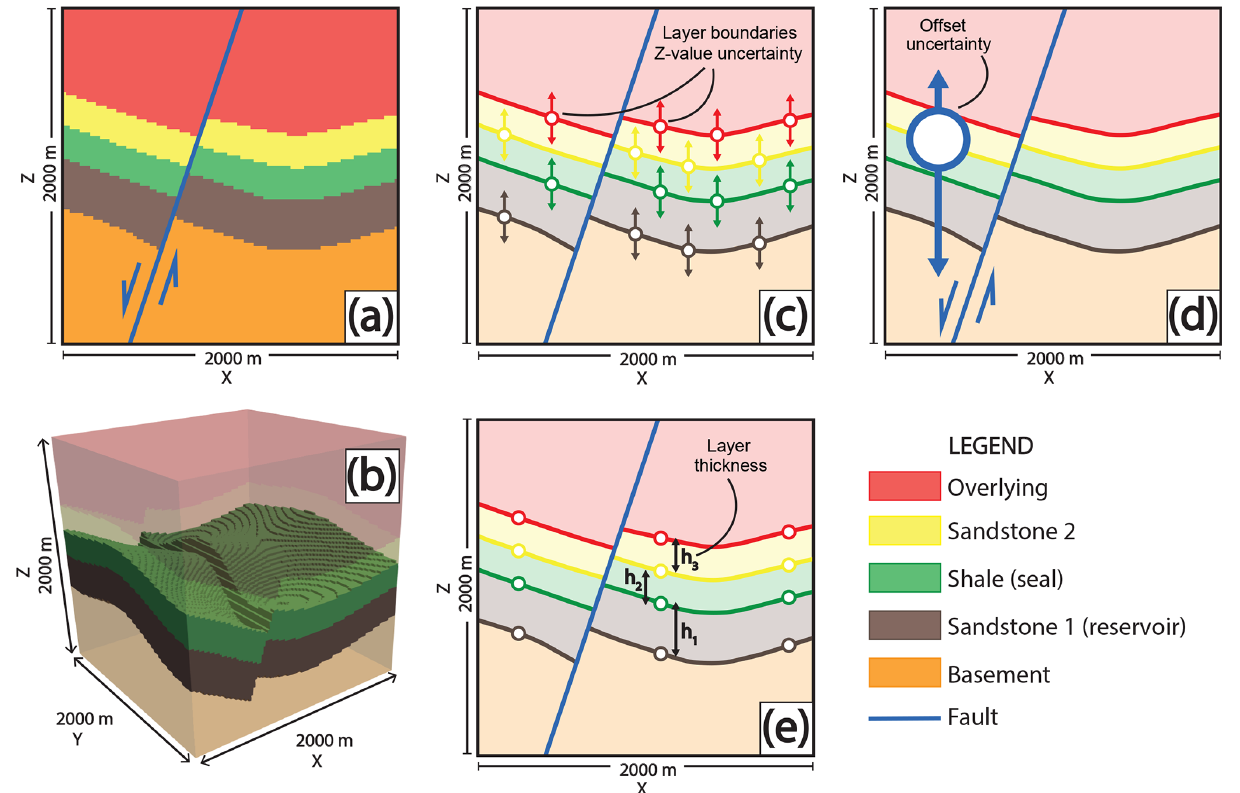
Figure 3. Design of the 3-D structural geological model. A 2-D cross section through the middle of the model ( y = 500m), perpendicular to the normal fault (parallel to the x – z plane), is shown in (a) . A 3-D voxel representation of the model, highlighting the reservoir and seal formations, is visualized in (b) . In (c) and (d) , the inclusion of parameter uncertainties is presented. Colors indicate certain layer bottoms (i.e., boundaries) that are assigned shared z -positional uncertainties (c) . All points in the hanging wall are additionally assigned a fault offset uncertainty (d) . Thicknesses of the three middle layers are defined by the distances of boundary points (e) and are thus directly dependent on (c)